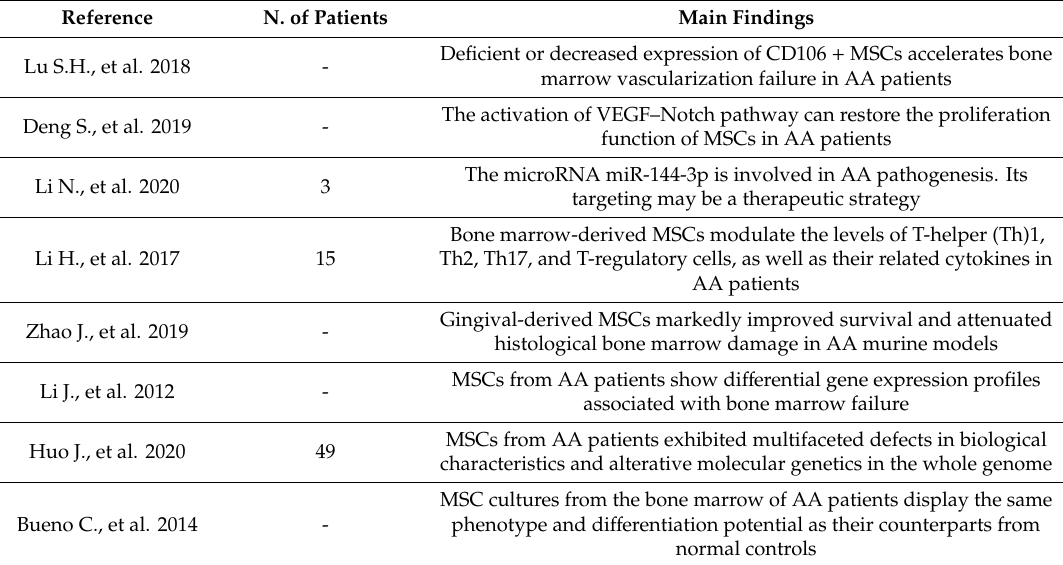
Table 1. Characteristics of mesenchymal stem cells (MSCs) in aplastic anemia